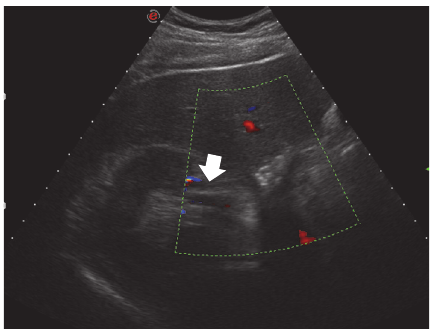
Figure 2: Ultrasonography of the abdomen with convex probe, transverse scan, color-Doppler study: at the level of the right kidney, there is lack of flow involving the median branch of a triple renal artery (arrow).